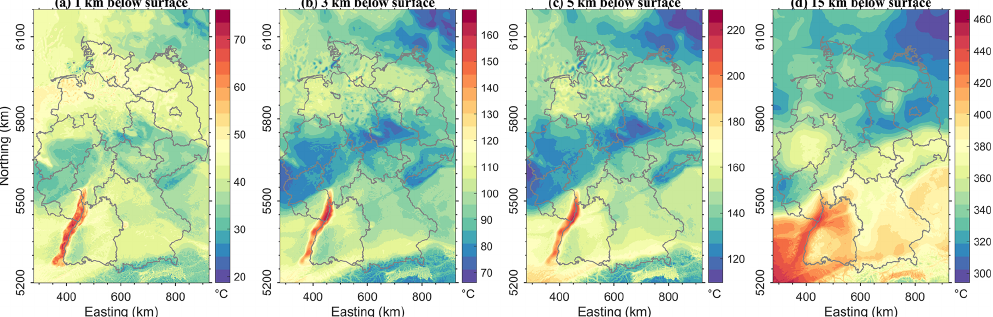
Figure 4. Modelled temperatures at: (a) 1km; (b) 3km; (c) 5km; (d) 15km depth below surface. Colour bars show temperature in ◦ C.